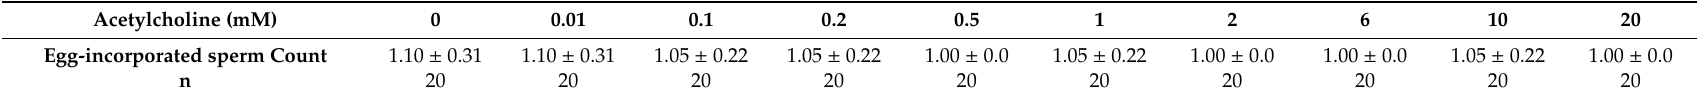
Table 2. Acetylcholine fails to induce polyspermy also in the dejellied